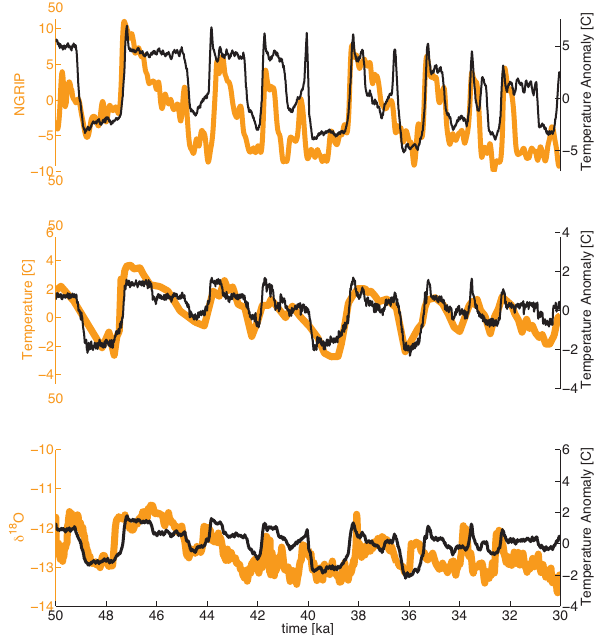
Fig. 3. From top to bottom: time series of simulated northeast- ern Greenland air temperature anomalies (40 ◦ W–10 ◦ E, 66–85 ◦ N) compared to the NGRIP temperature reconstruction (Huber et al., 2006); simulated SST in the western Mediterranean compared to alkenone-based SST reconstructions from the Alboran Sea ODP hole 161-977A (Martrat et al., 2007) and simulated air tempera- ture anomalies over Turkey (25–46 ◦ E, 35–42 ◦ N) compared to a speleothem δ 18 O record (‰) from Sofular Cave, Turkey (Fleitmann et al., 2009). Model results are in black and paleoproxy records in